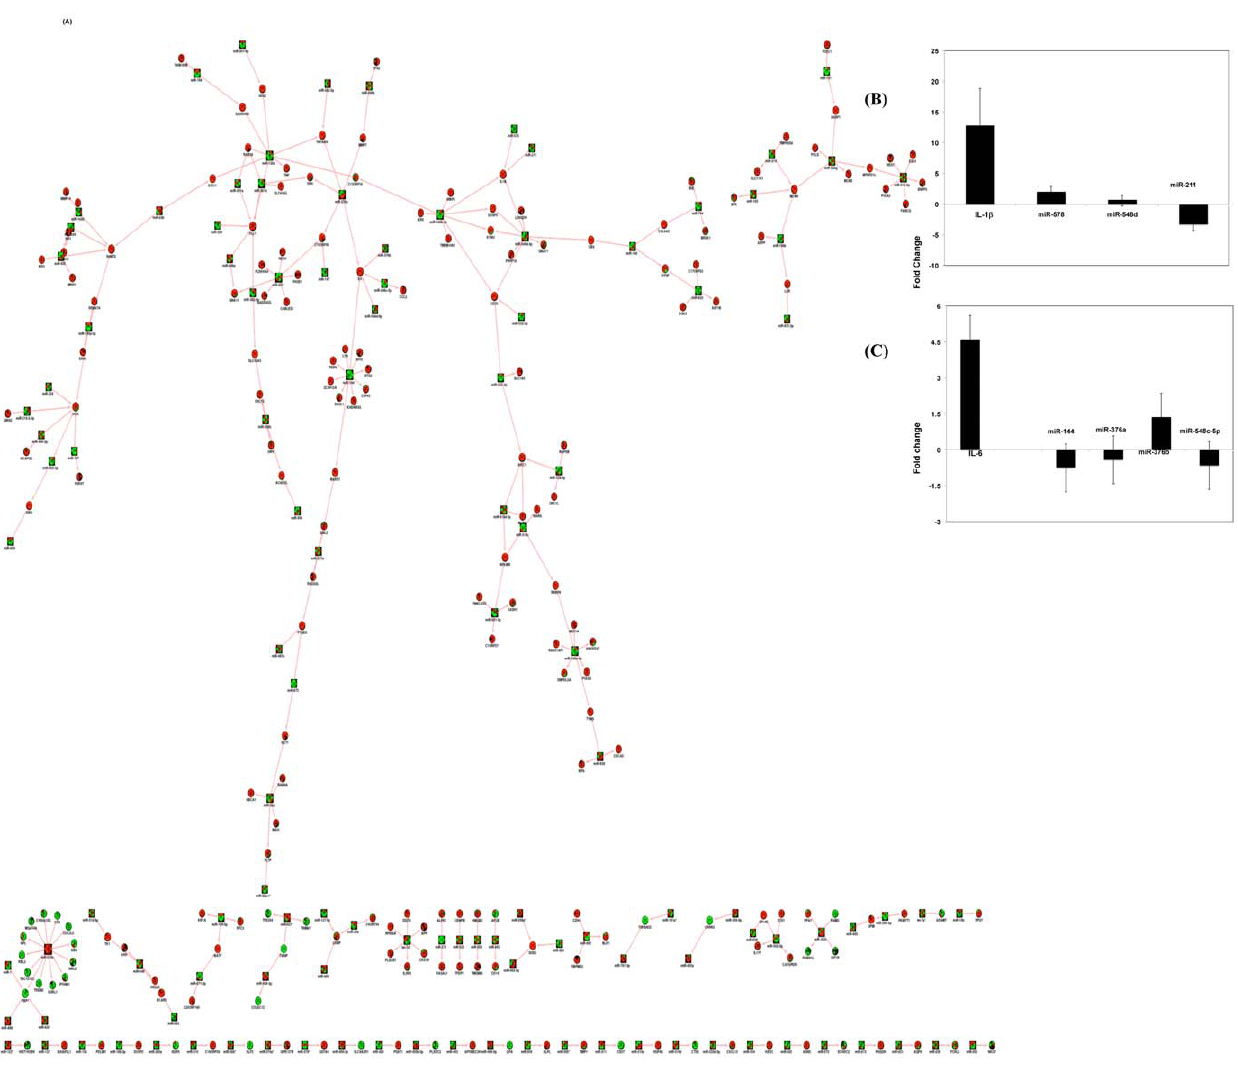
Figure 5. Network of predicted miRNA-mRNA interactions. (A) Regression-based method was used to predict the miRNAs (green circles) that are actively regulating mRNAs (red diamonds) in our dataset. (B&C) Validation of miRNA-mRNA interaction partners by RT-PCR using independent samples (n=6) for IL-1ß(B) and IL-6 (C).